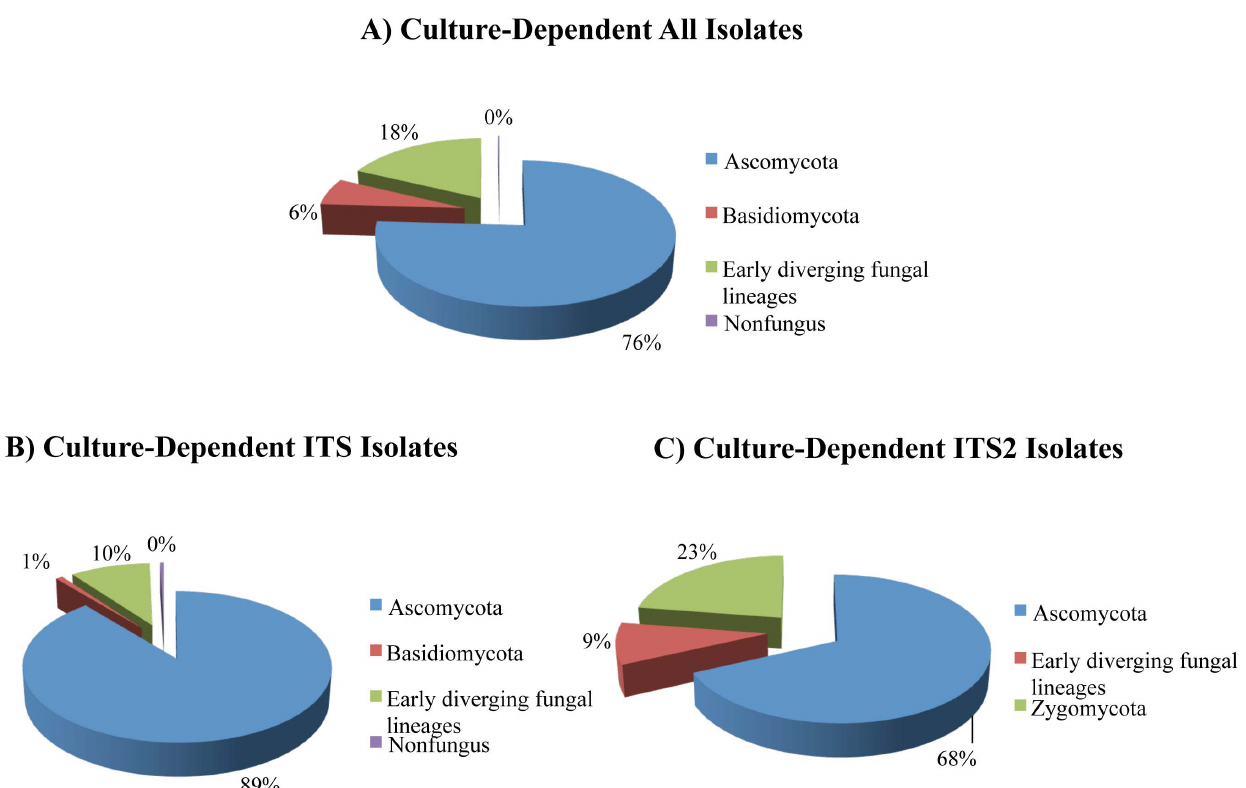
Figure 1. Fungal isolates recovered by culture-dependent methods. (A) Relative distribution of all cultures according to different fungal phyla; (B) Relative distribution of isolates identified by homologies to ITS sequences; (C) Relative distribution of isolates identified by homologies to ITS2 sequences. The zero percent assigned in pie chart represents isolates with less than 1% relative distribution.